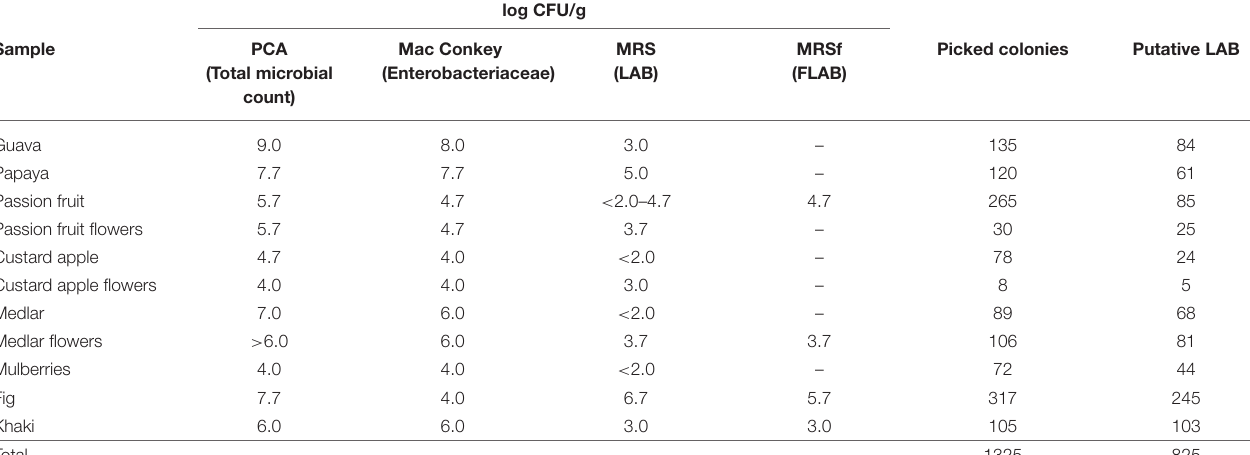
TABLE 2 | Viable colony counts of total bacteria (PCA agar), enterobacteria (Mac Conkey agar), and LAB (MRS and MRSf agar) in fruit and flower samples. log